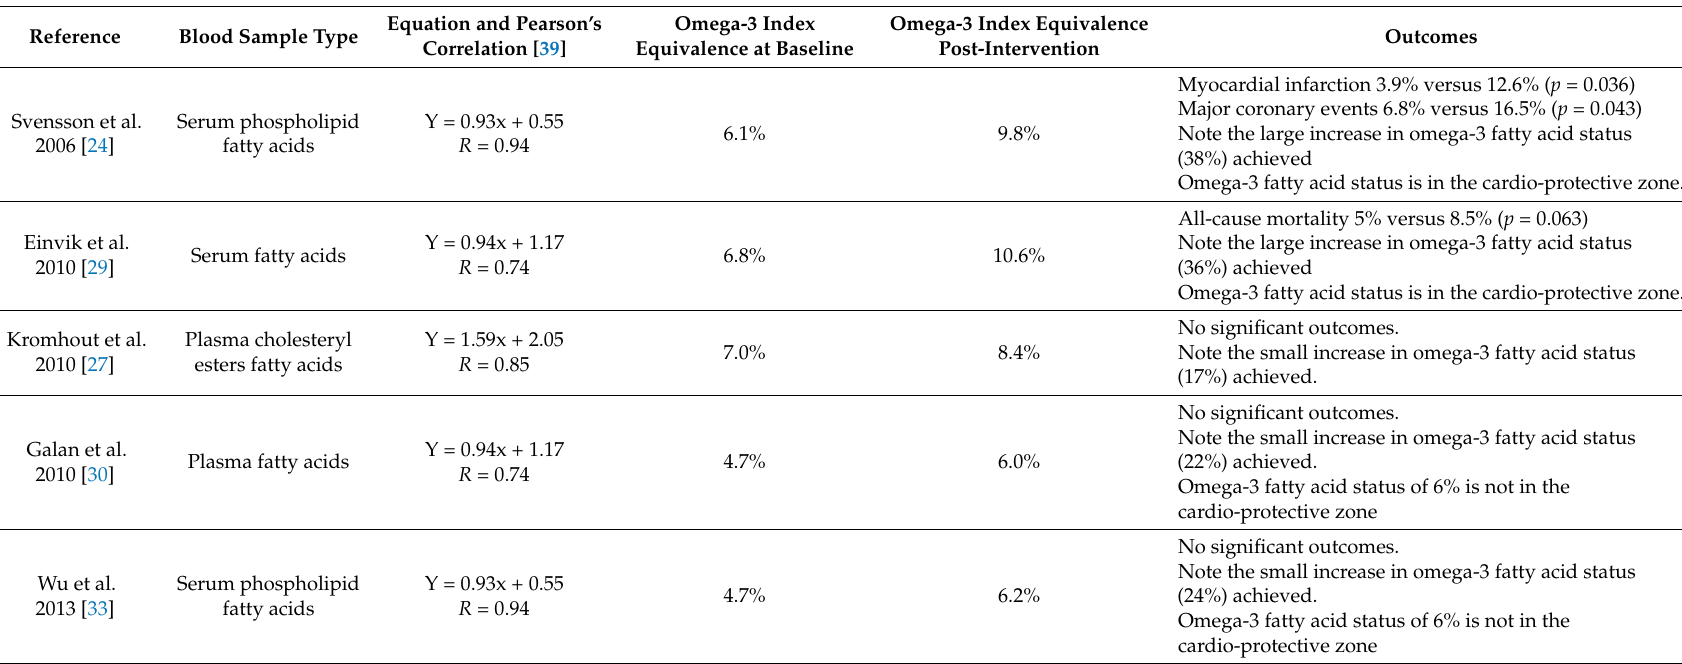
Table 1. Randomised controlled trials (RCTs) of the effect of omega-3 supplementation that included blood sampling at baseline and